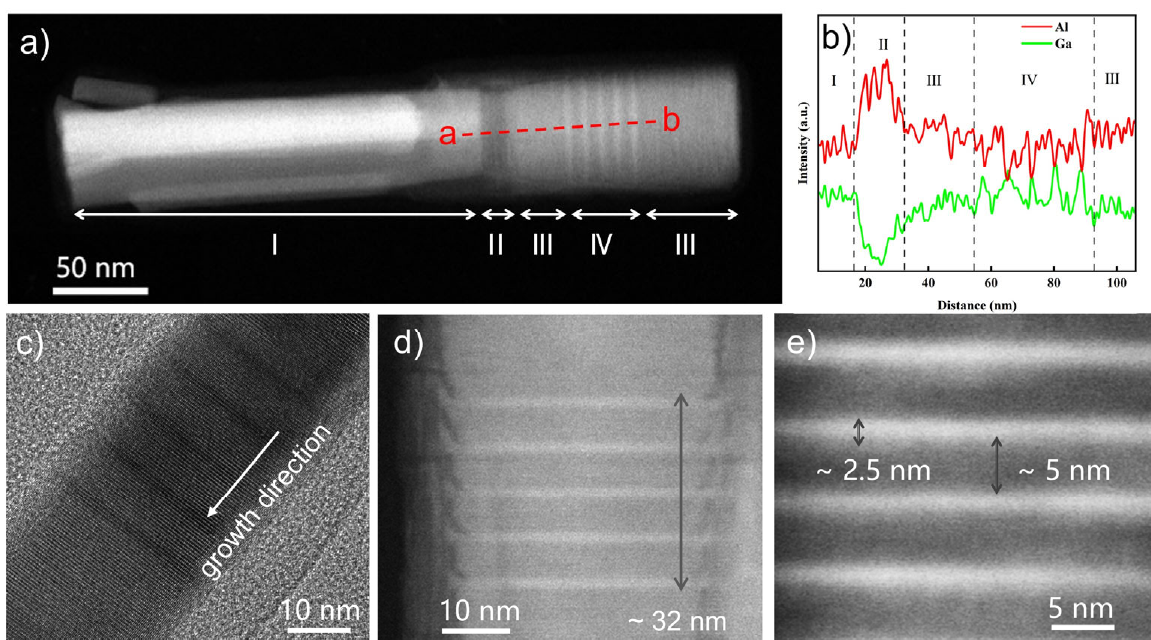
Figure 3. ( a ) STEM image of a single AlGaN nanowire, ( b ) EDX image along the growth direction, ( c ) HR-TEM images of the Qdisks region. ( d,e ) STEM images of the Qdisks region.